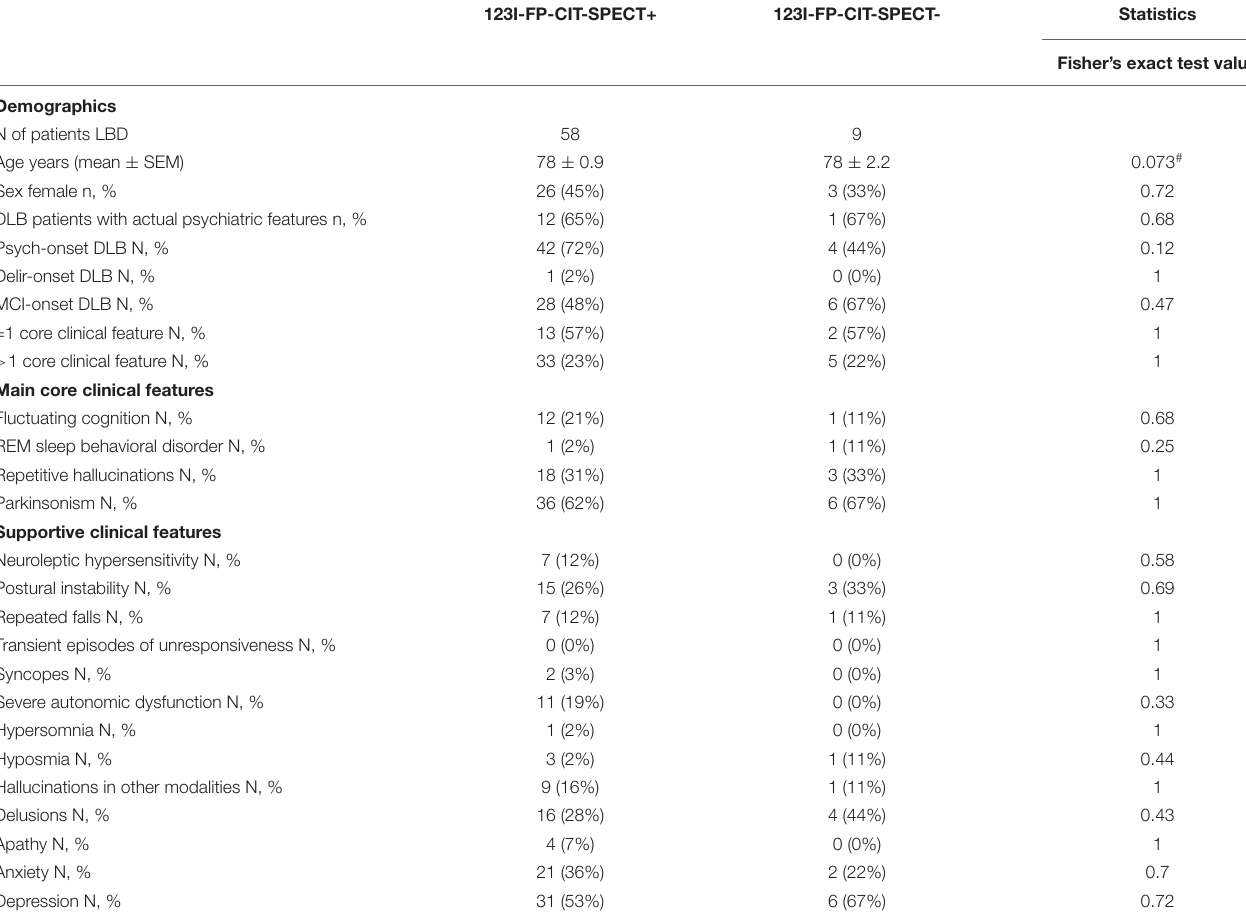
TABLE 1B | Characteristics of groups with and without a nigrostriatal dysfunction in 123I-FP-CIT-SPECT.